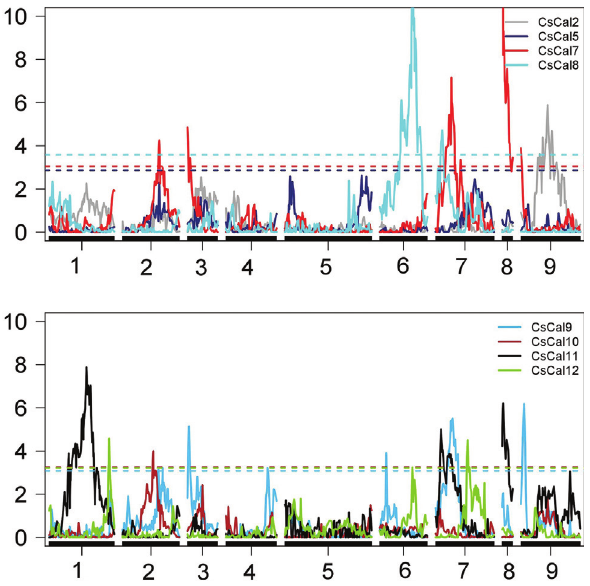
Figure6 -DetectionofeQTLinthe C.sunki linkagemaprelatedtotheex- pression of the CscalS genes evaluated. Y-axis: LOD; X-axis: distance in centiMorgans; the dashed lines represent threshold values obtained using 1000